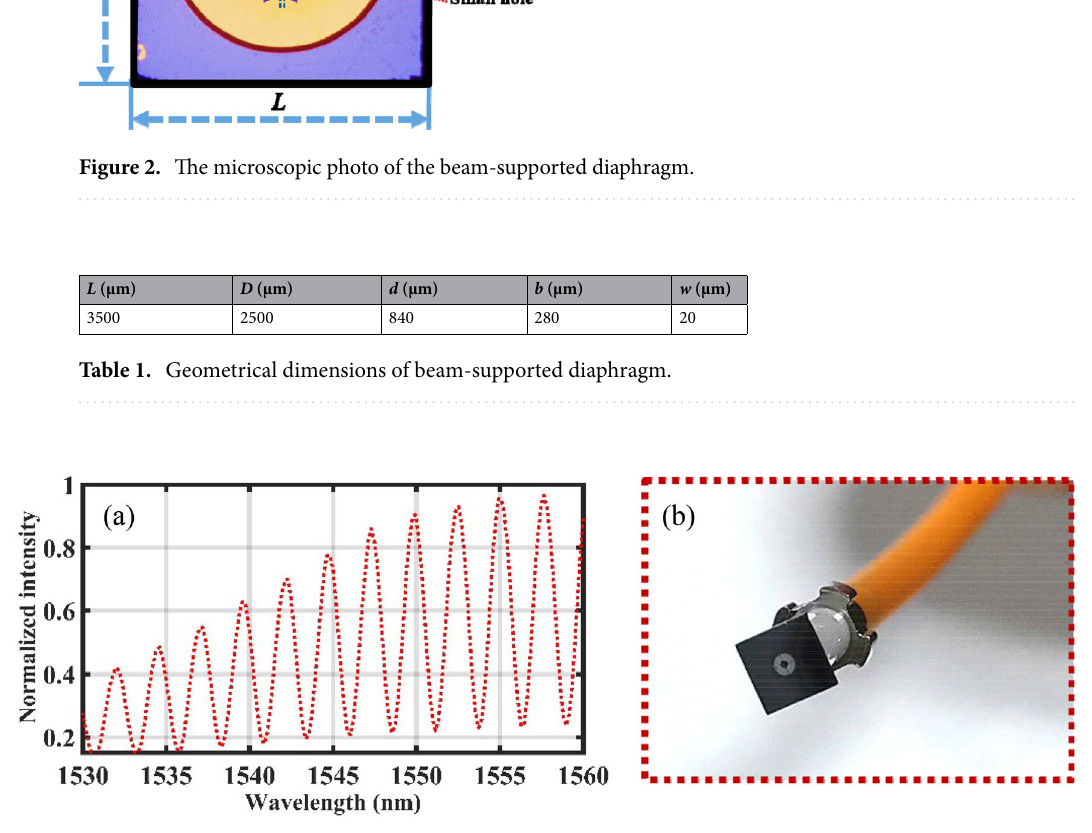
Figure 3. ( a ) The interference spectrum of Fabry–Perot (FP) cavity. ( b ) The finally assembled sensing element.